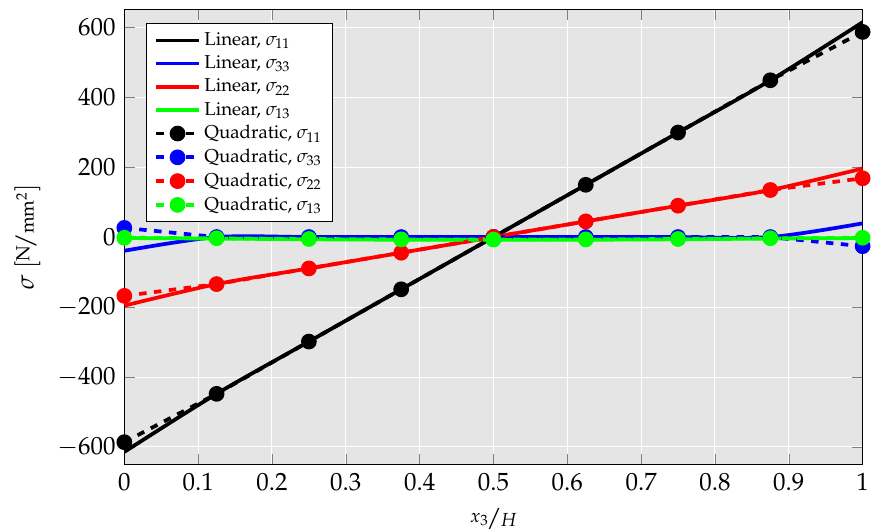
Figure 16. Comparison of mechanical stress components calculated by using linear and quadratic element along the height of the beam for prescribed mechanical displacement.